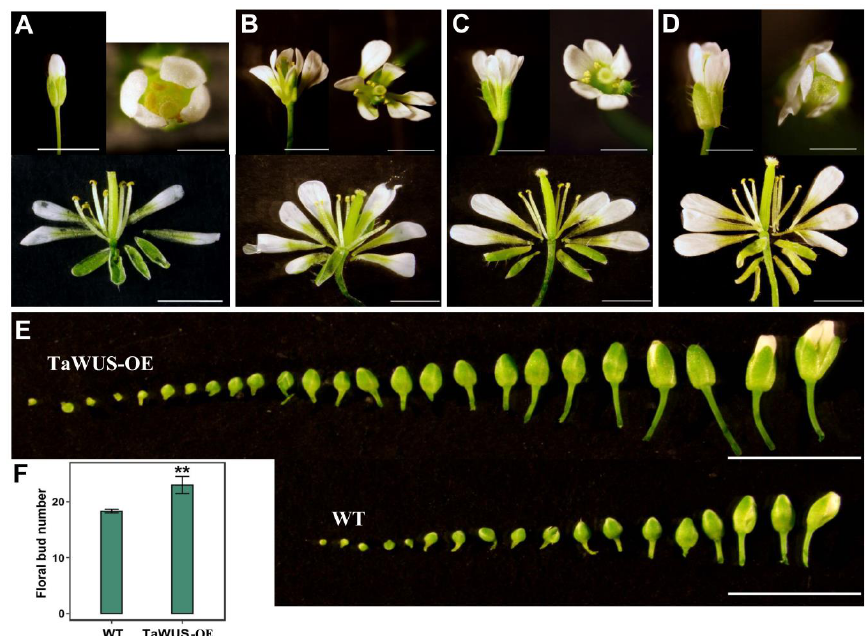
Figure 6. Overexpression of TaWUS (TaWUS-OE) in Arabidopsis . ( A ) Floral structure of wild Arabidopsis (WT). ( B – D ) Floral structures of TaWUS-OE. More petals were observed in ( B – D ) and more sepals in ( D ). ( E , F ) Inflorescence of TaWUS-OE showed a greater number of flower buds ( n = 10), p < 0.001. Statistical significance was evaluated using Student’s t -tests. ** means very significant di ff erence. TaWUS-OE and WT stages 7 to 12 floral buds count in 40-day-old plants (Supplementary Figure S5E). Scale bars = 0.5 cm ( A – D ); Scale bars = 1 cm ( E ). The above phenotypes were derived from two independent transgenic